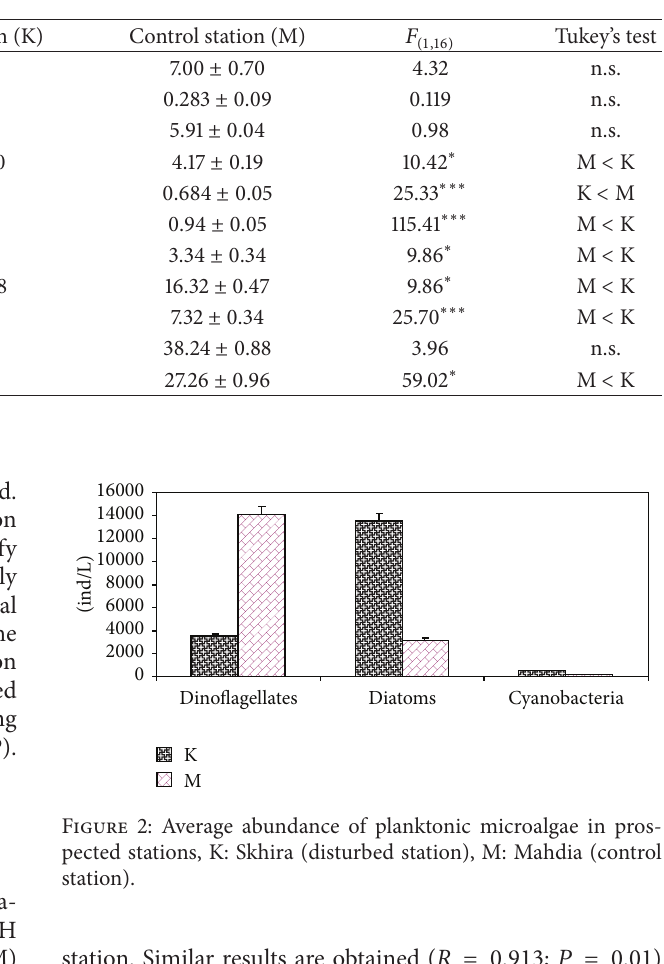
Table 1: The mean ± SD values of physical and chemical variables measured at all stations during the sampling period. Difference between control station (M) and disturbed station (K) was tested by ANOVA.